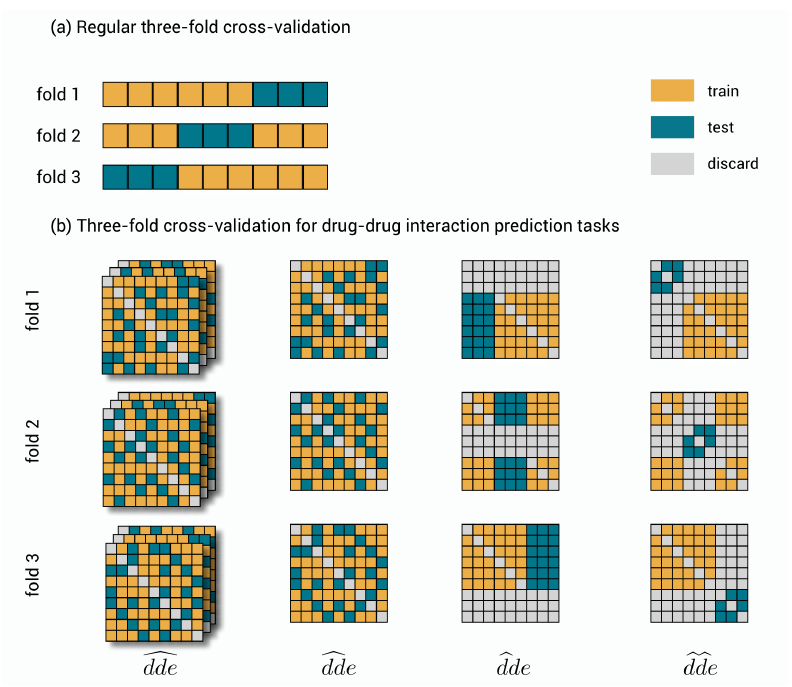
Figure 2. Cross-validation. ( a ) Three-fold cross-validation for a traditional data set. The data set is shown three times, where each time another chunk is used for evaluating the model and the remaining part for training. ( b ) Three-fold cross-validation for the polypharmacy prediction tasks. A symmetric toy data set of nine by nine drug–drug-pairs and three distinct effects. In (cid:100) dde , triplets are randomly, but symmetrically assigned to one of the folds. In (cid:99) dde , drug–drug pairs are randomly but symmetrically assigned to one of the folds. As this assignment is the same for each effect, only one slice is shown. In (cid:98) dde , drugs are as a whole assigned to one of the folds. Note that the symmetric counterpart is to be discarded. This assignment is again the same for each effect slice. In (cid:98) d (cid:98) de , drug–drug-pairs are as a whole assigned to one of the folds, but now both drugs need to be test drugs and any other interaction is to be